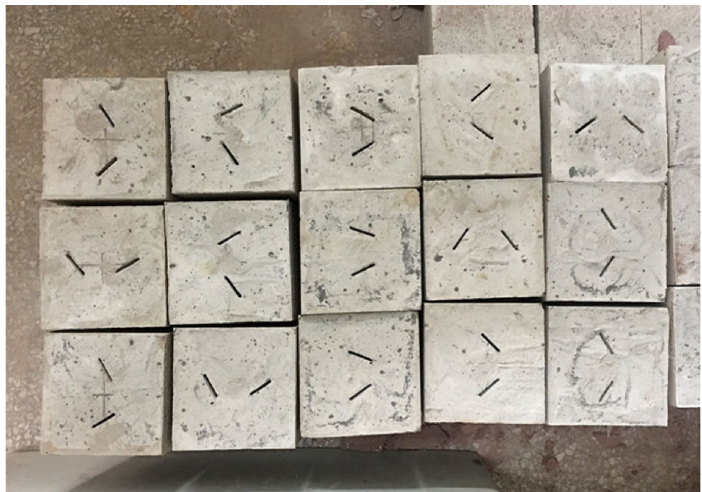
Fig. 3 Photos of part completed